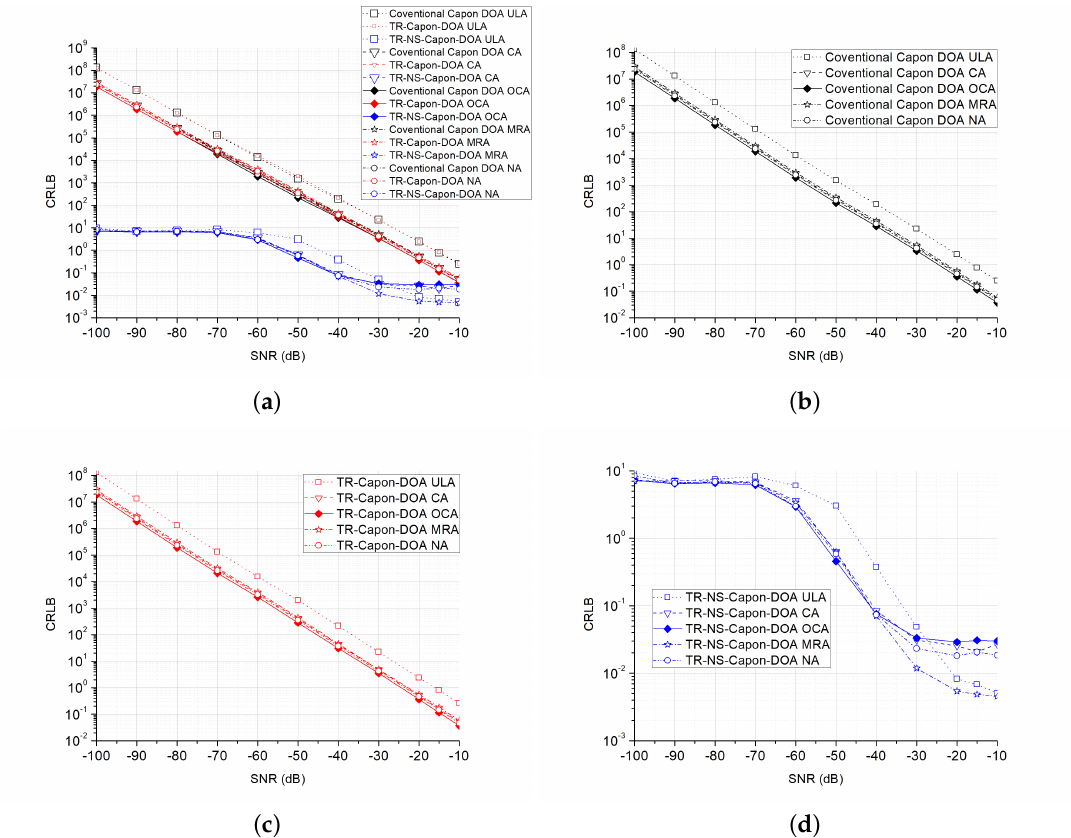
Figure 16. CRLB versus SNR for conventional Capon DOA, TR-Capon-DOA and TR-NS-Capon-DOA algorithms with the configurations of ULA, CA, OCA MRA and NA under the condition of LFM used as ES and DOA = 40 ◦ , ( a ) all methods and configurations; ( b ) the conventional method and all configurations; ( c ) the TR-Capon-DOA method and all configurations; ( d ) the TR-NS-Capon-DOA method and all